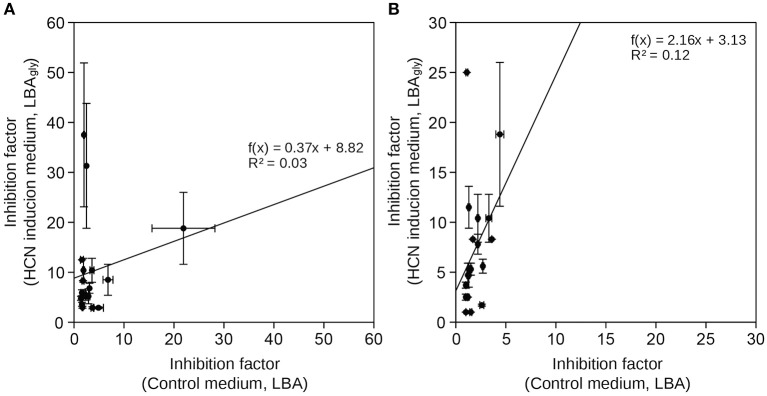
Comparison of inhibition of growth of phytopathogenic fungi by HCN+ and HCN− rhizobacterial isolates. Inhibition factors were calculated on control medium, not inducing HCN production (LBA) and on growth medium inducing HCN production (LBAgly). (A) HCN+ strains (B) HCN− strains. Data represents average ± SD (n = 4).